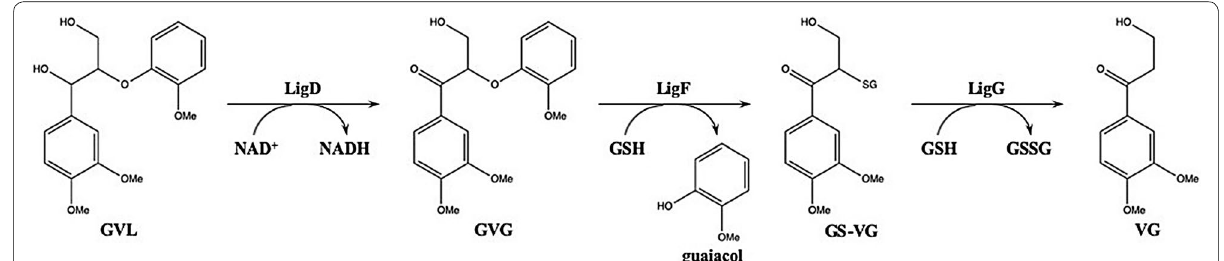
Fig. 1 Reaction procedure of the LigDFG enzyme system. GSH, reduced glutathione; GSSG, oxidized dimer glutathione; GVL, guaiacyl-α-veratrylglycerol; GVG, β-guaiacyl-α-veratrylglycerone; GS-VG, β-glutathionyl-α-veratrylglycerol; VG,